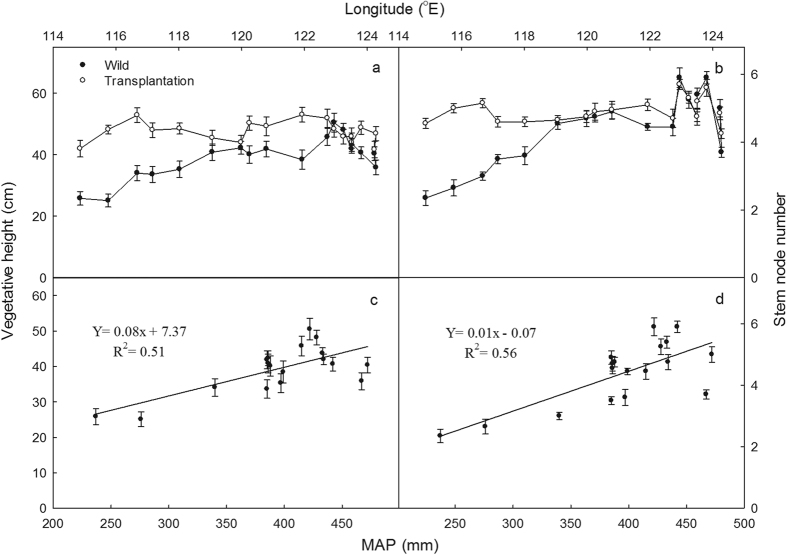
Vegetative shoot height (a), stem node numbers (b) in wild sites and transplantation and their regressions with mean annual precipitation (MAP) (c,d) in L. chinensis along the large-scale gradient.